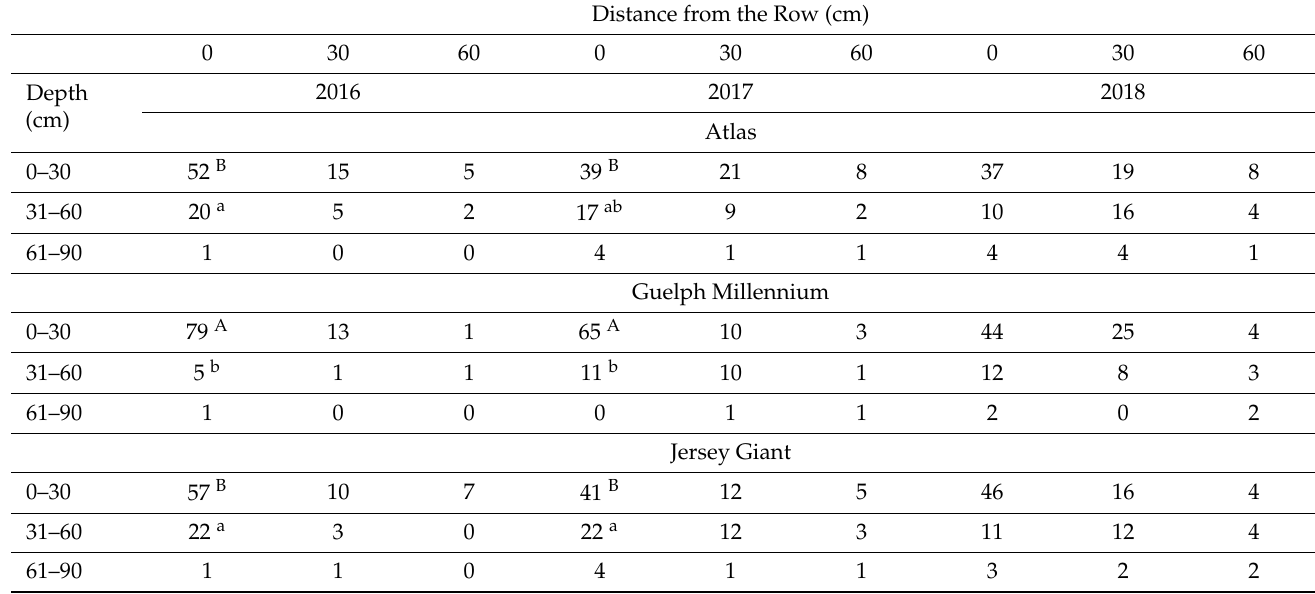
Table 1. Percentage of fleshy storage roots by depth and distance for three asparagus cultivars (Atlas, Guelph Millennium, Jersey Giant) during the early establishment years (2016–2018). Transplants planted in April 2015 and root growth assessed in May of 2016–2018. Distance from the Row